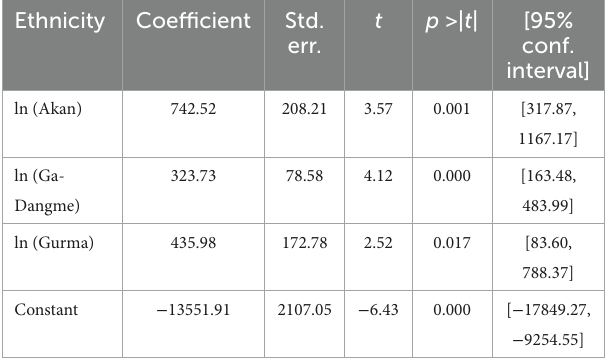
TABLE 2 Regressing COVID on ln (ethnicity).